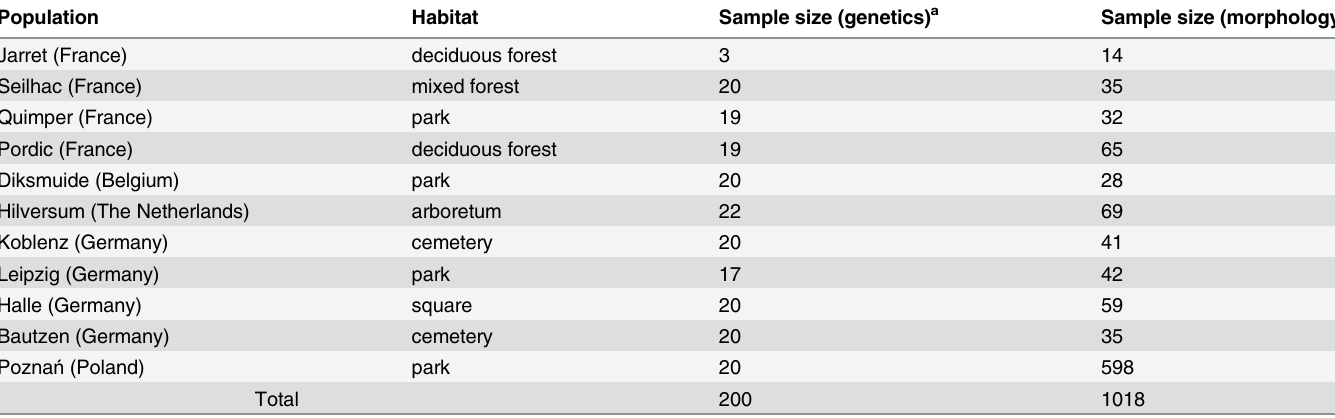
Table 1. Geographic location, habitat and sample sizes for the genetic and morphological analyses in the 11 sampled populations of H . subterraneus